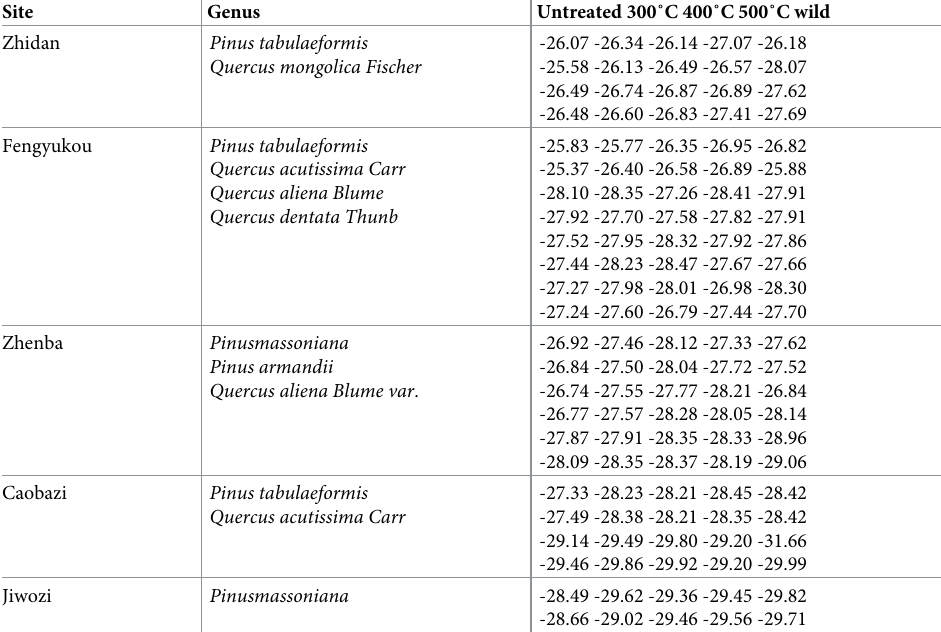
Table 2. δ 13 C (‰ VPDB) of wood samples heated at different